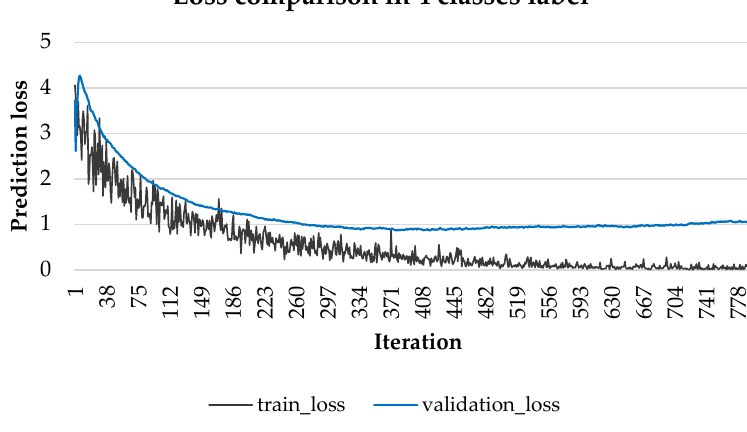
Figure 6. Four class loss to find the optimal training point.